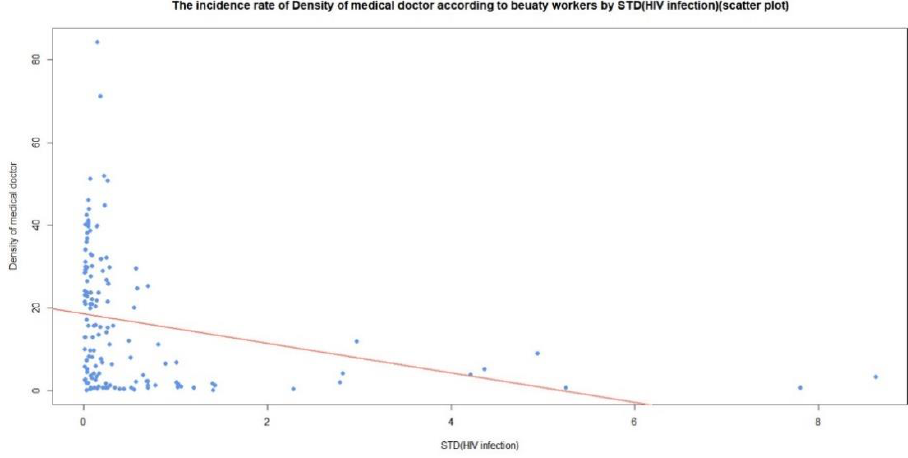
Figure 17. Scatterplot for STDs (HIV infection) and density of medical doctors.